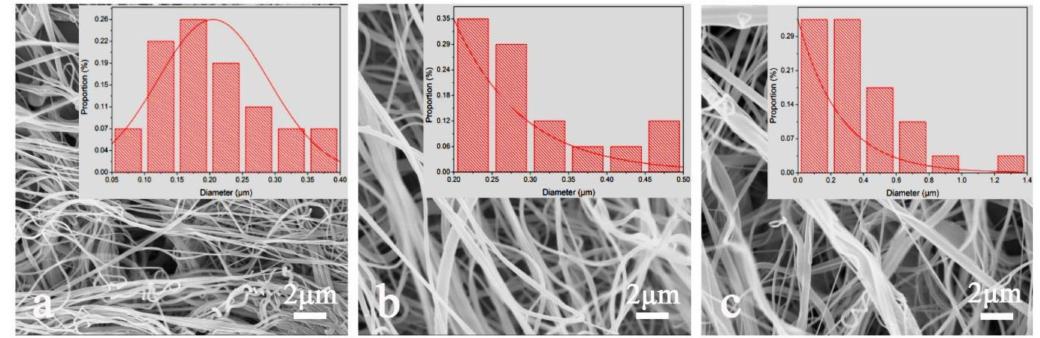
Figure 2. Scanning electron microscopy (SEM) images of nylon 6 nanofiber at different solution concentrations, ( a ) 12 wt %, ( b ) 15 wt % and ( c ) 18 wt %. Inset are their size distribution curves.